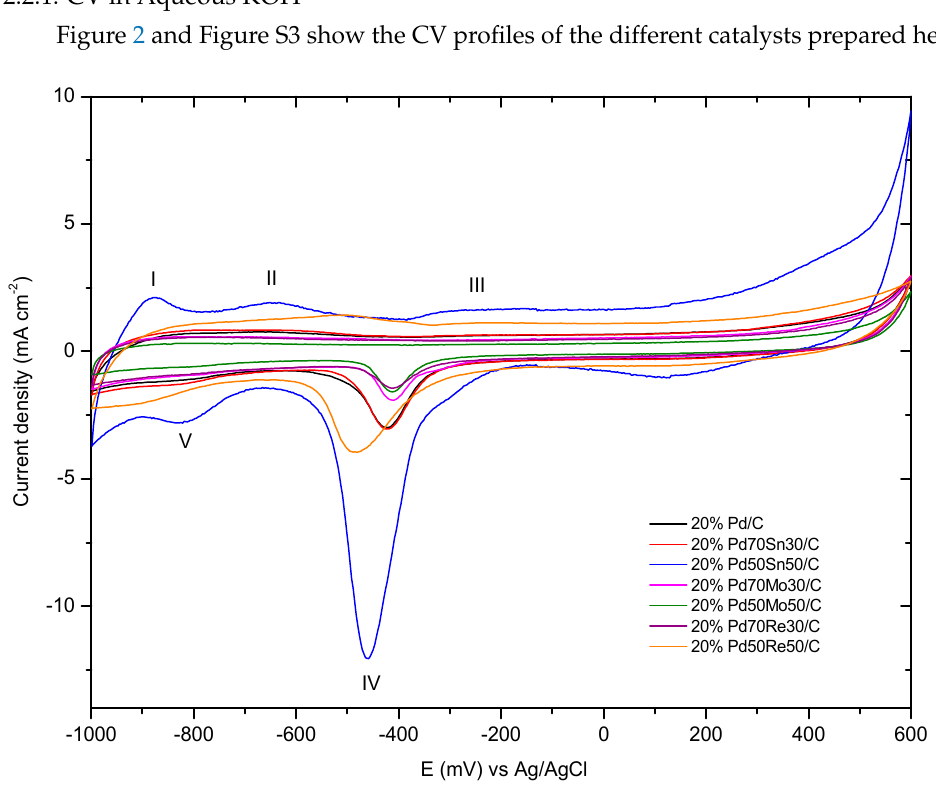
Figure 2. Cyclic voltammograms of 20% Pd/C, 20% Pd 70 Sn 30 /C, 20% Pd 50 Sn 50 /C, 20% Pd 70 Mo 30 /C, 20% Pd 50 Mo 50 /C, 20% Pd 70 Re 30 /C and 20% Pd 50 Re 50 /C in KOH 1.0 M. E (mV) vs. Ag/AgCl (3 M). (Scan rate: 50 mV s − 1 at room temperature).